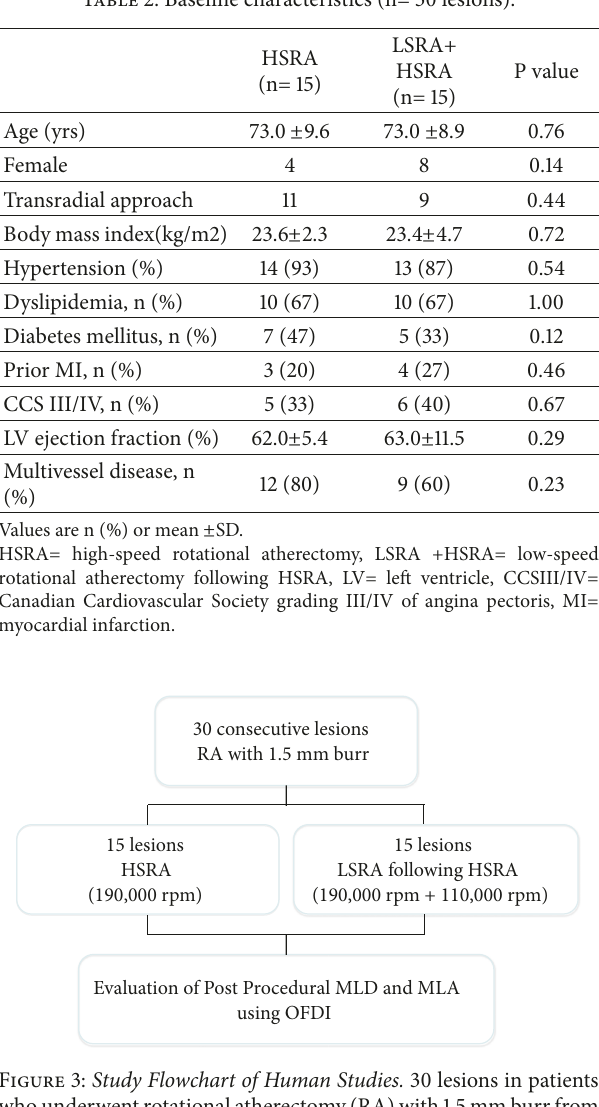
Table 2: Baseline characteristics (n= 30 lesions).